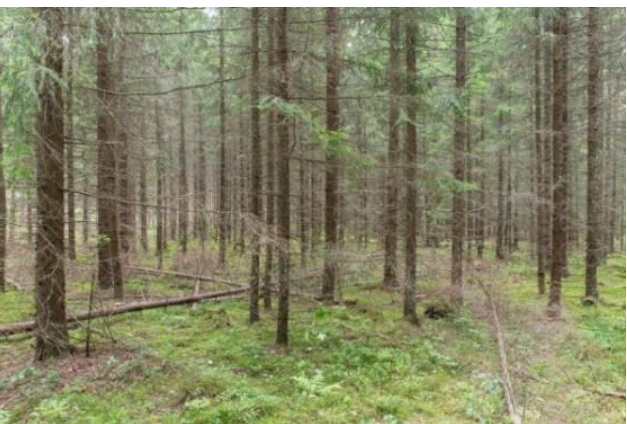
Figure 4. The young commercial forest (Young). This picture was published in Reference [66].